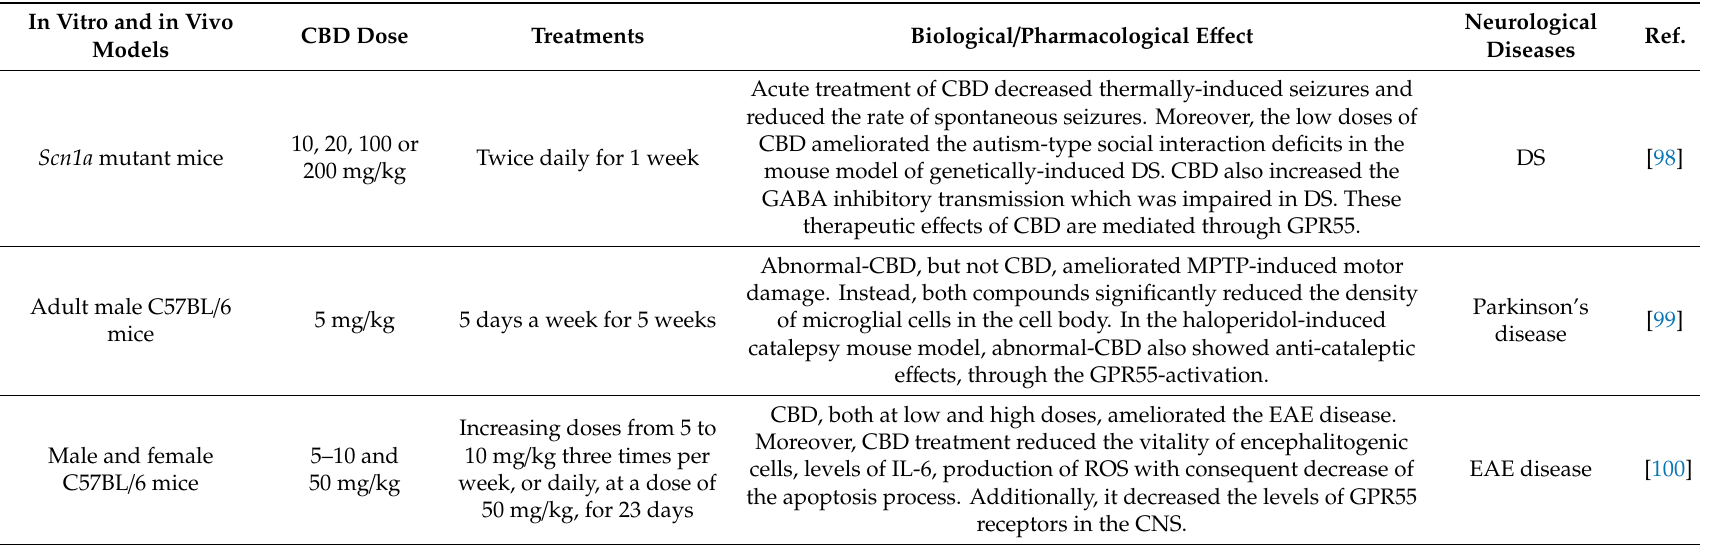
Table 3. Neuroprotective e ff ects of CBD in di ff erent neurological diseases through the antagonize activation of the